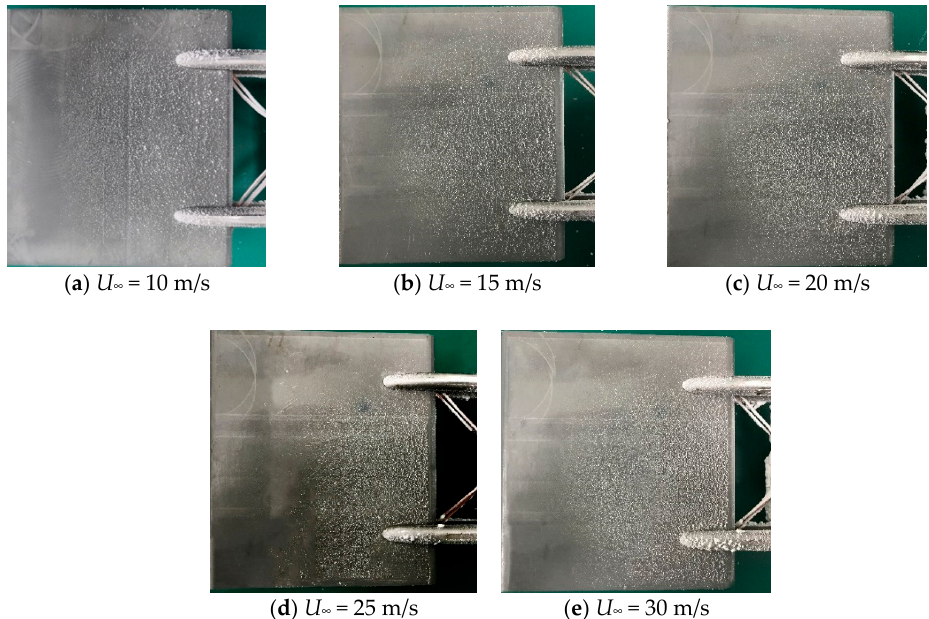
Figure 10. Photographs of wax deposition on lee surface with different mainstream velocities.